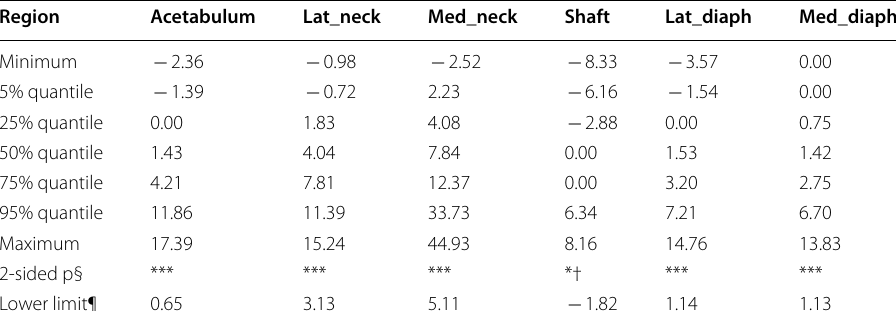
around prostheses by MAR CT mean